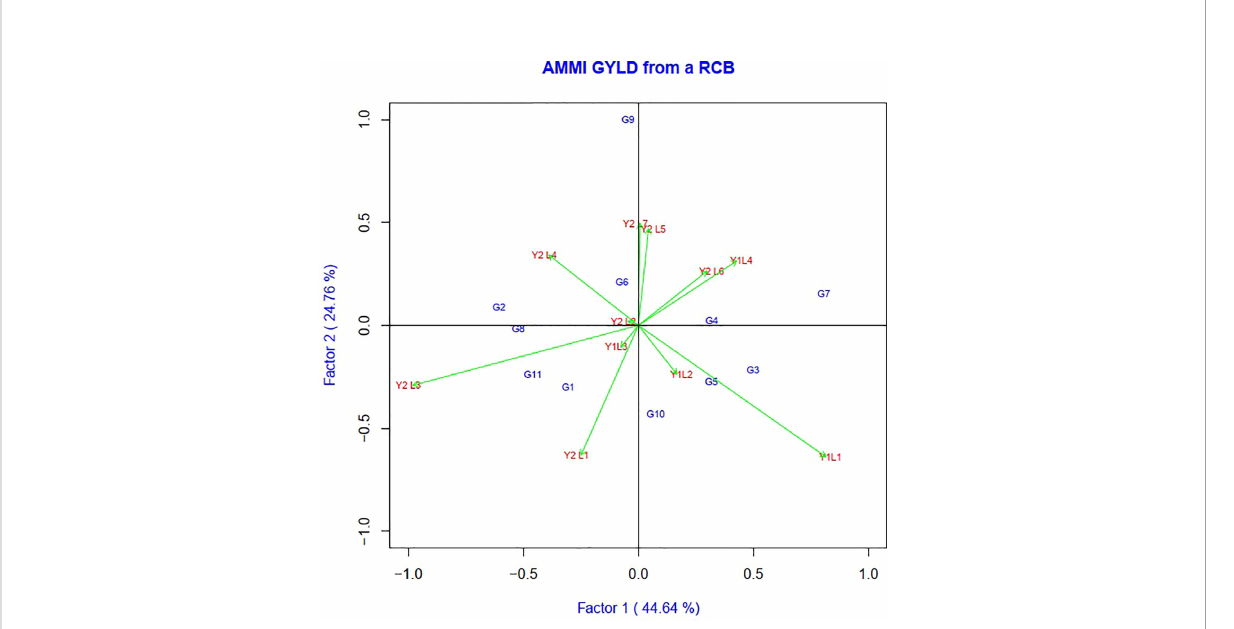
FIGURE 2 The biplot ‘ AMMI 2 ’ illustrated the fi rst two principal components (PC1 and PC2) effects of genotype plus GE interaction effect of 11 soybean genotypes under two years (11environemnets) for grain yield per hectare. The biplots were created based on Centering = 0, SVP = 2, Scaling =